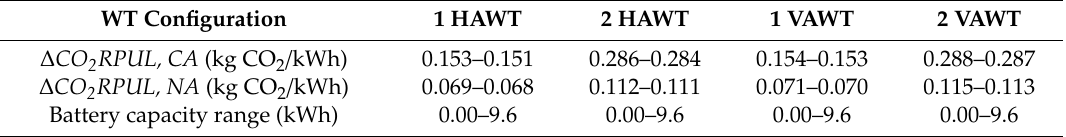
Table 8. ∆ CO 2 RPUL as a function of WT configuration, location, and battery storage capacity.